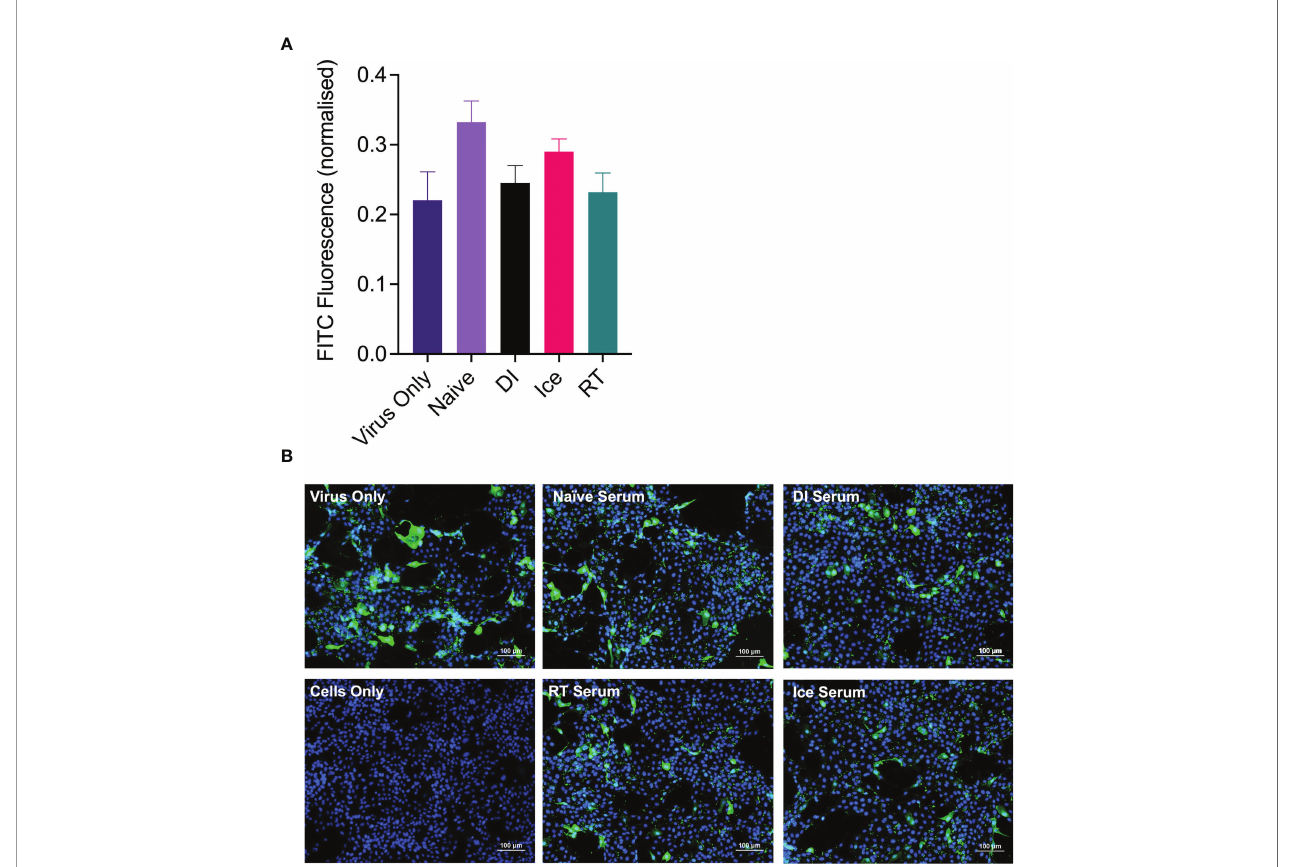
FIGURE 7 | g -Flu does not induce cross-neutralising antibody responses. Mice were vaccinated intranasally with g -Flu ( g -A/PR8 H1N1) irradiated at room temperature (RT), on ice water (Ice) or on dry ice (DI). 20 days post-vaccination immune serum was harvested and the ability to neutralise A/California was measured by focus-forming inhibition assay. Live A/California was treated with pooled serum samples from the three vaccine groups or with serum from mock-vaccinated mice. Virus + serum mixtures were used to infect MDCK cell monolayers at MOI of 0.1. (A) FITC- fl uorescence (green) indicative of A/California replication was measured relative to DAPI- fl uorescence (blue), indicative of cell nuclei. (B) Representative images of cell monolayers showing A/California infection levels after pre-treatment with a 1:10 dilution of serum samples. Experiments were performed in triplicate and quantitative data was analysed by One-Way ANOVA. Data was not signi fi